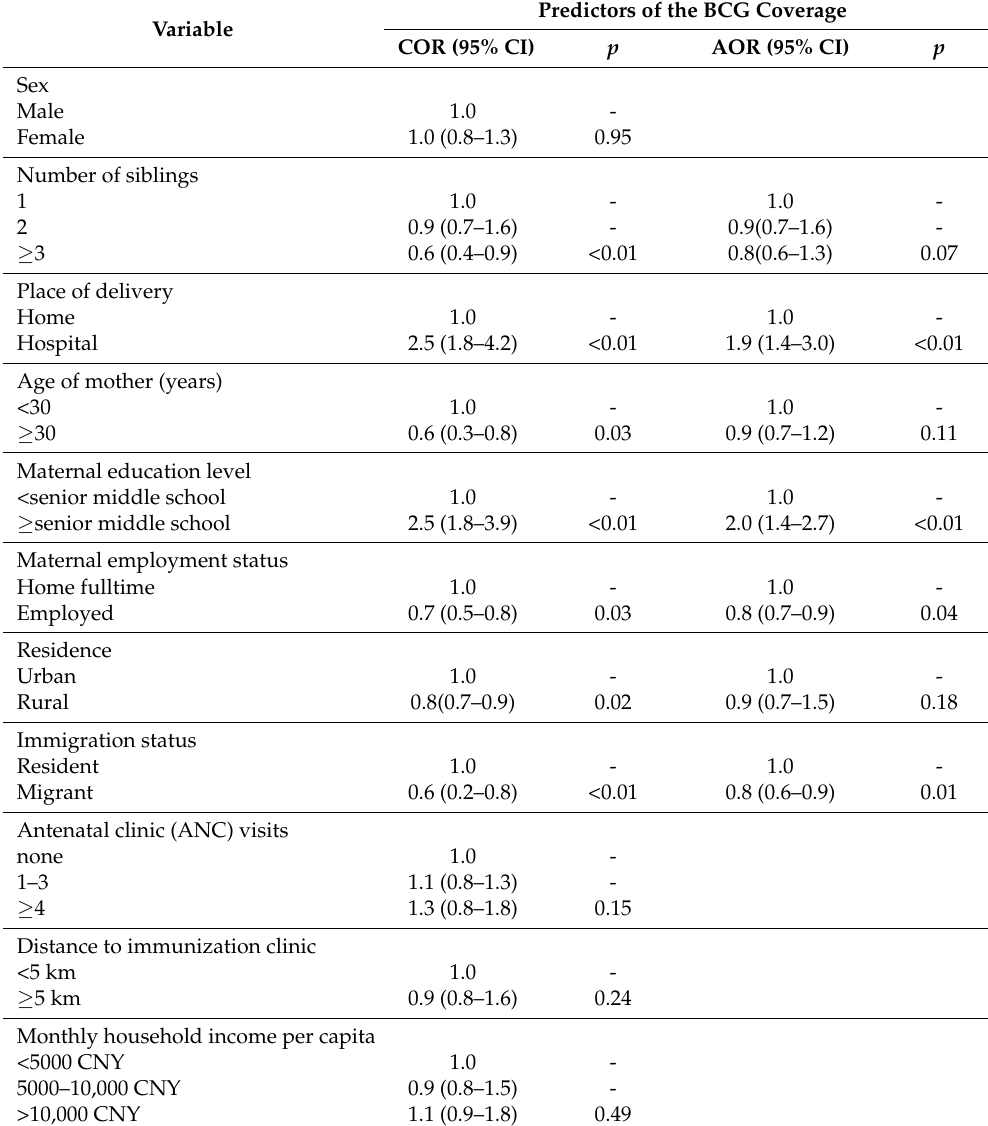
Table 3. Univariate and multivariate analyses of the predictors associated with the BCG vaccination. Predictors of the BCG Variable